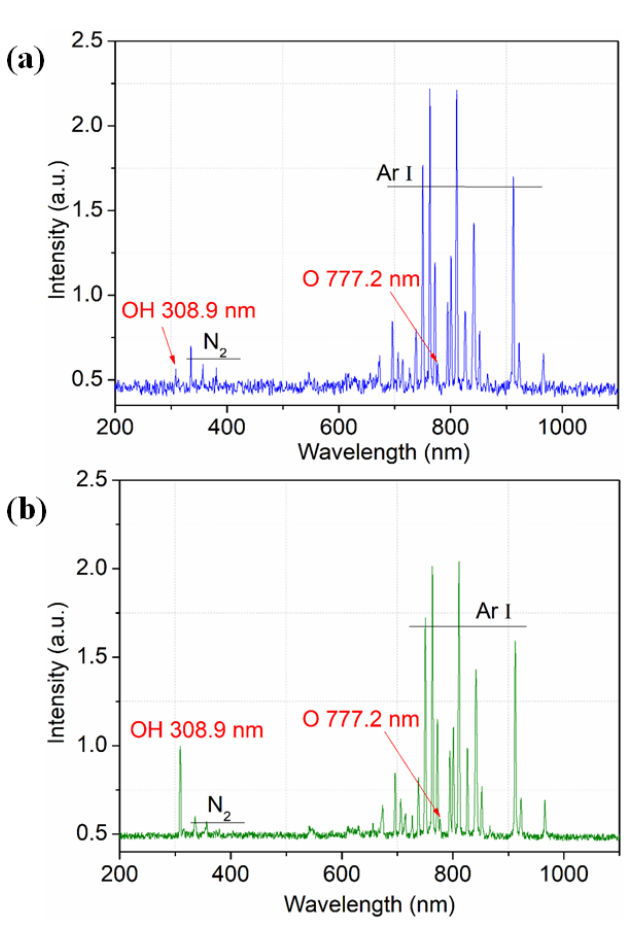
Figure 3. Emission spectra of microplasma jets excited by ( a ) pure Ar and ( b ) Ar/H 2 O in ambient air conditions.